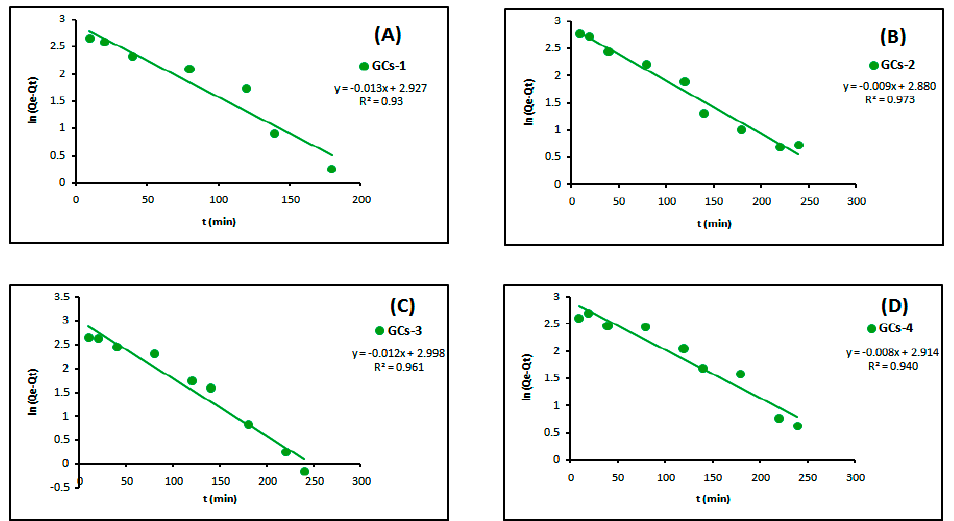
Figure 11. Pseudo-first order kinetics models of nickel adsorption using ( A ) GCs-1; ( B ) GCs-2; ( C ) GCs-3 and ( D ) GCs-4.